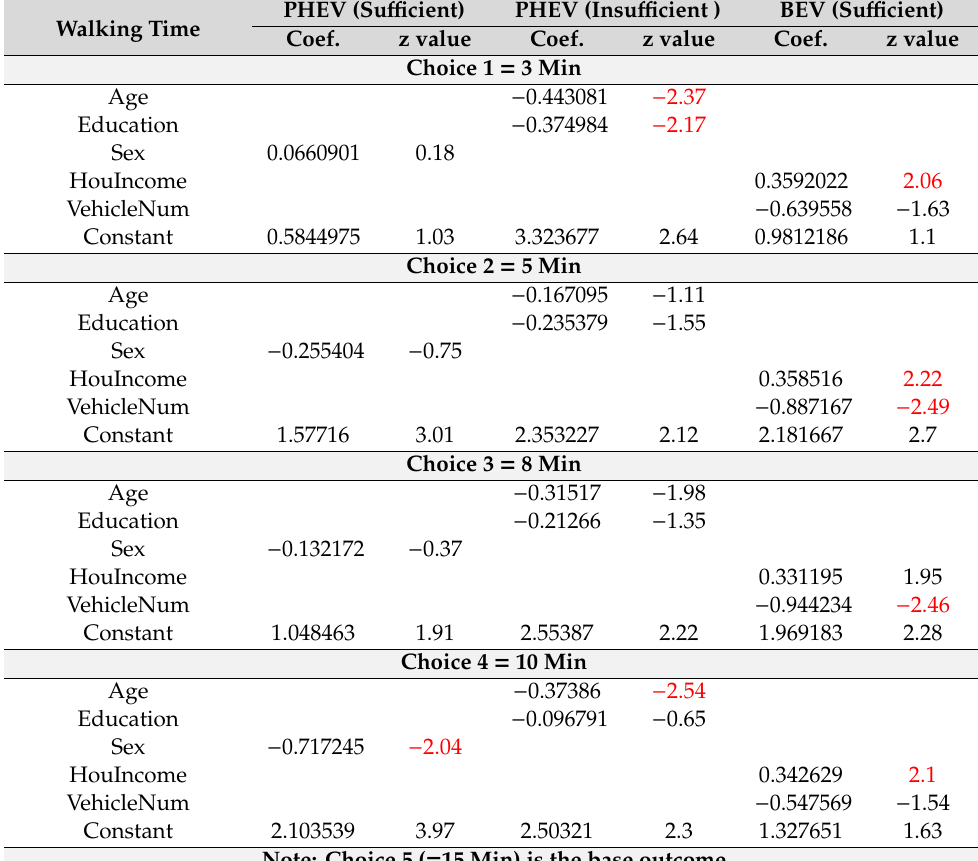
Table 3. MNL models for the influence of the availability of charging posts on the walking time. PHEV (Su ffi cient) PHEV (Insu ffi cient ) BEV (Su ffi cient) Walking Time Coef. z value Coef. z value